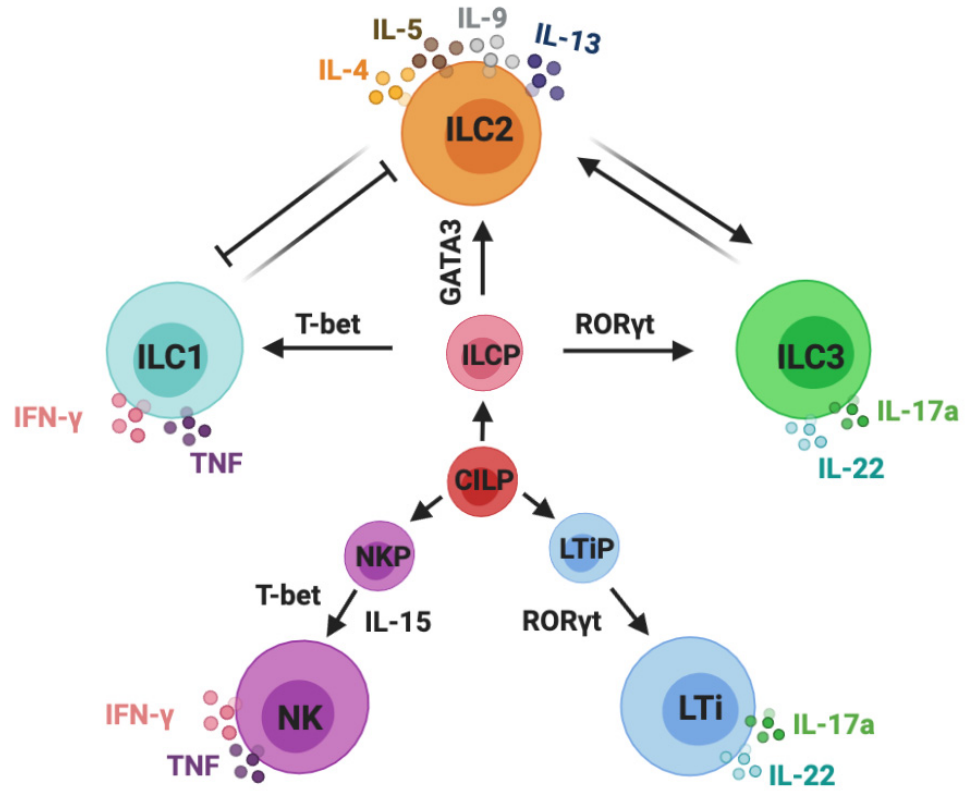
Figure 1. Classification of innate lymphoid cells. Innate lymphoid cells (ILCs) are derived from common innate lymphoid cells progenitors (CILP). Commonly accepted five subsets of ILCs: NK cells, ILC1s, ILC2s, ILC3s, and LTi cells. NK cells are derived from NK precursors (NKPs); ILC1s, ILC2s, and ILC3s are developed from ILC precursor cells (ILCPs); LTi cells are developed from LTi precursor cells (LTiPs). ILC1s and NK cells are categorized by their expression of T-bet and the production of IFN- γ and TNF- α ; ILC2s are defined by their expression of GATA3 and are characterized by their production of IL-4, IL-5, IL-9, and IL-13; ILC3s and LTi cells are specific for their expression of ROR γ t and production of IL-17A and IL-22. This schematic graphic shows the classification of ILCs; however, it does not draw all of the cytokines that are required for their development and activation or indicate all of the transcription factors and immune mediators expressed by ILCs.